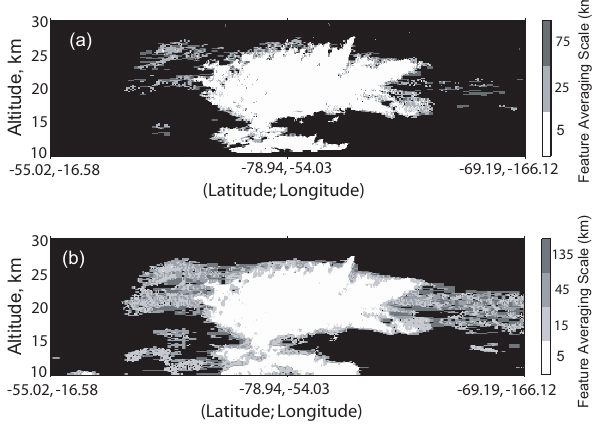
Fig. 2. PSC masks produced using the (a) v1 and (b) second- generation detection algorithms for an Antarctic cloud scene from 24 July 2006. The level of horizontal smoothing required to detect the cloud is indicated by the gray scale at the right of each image.